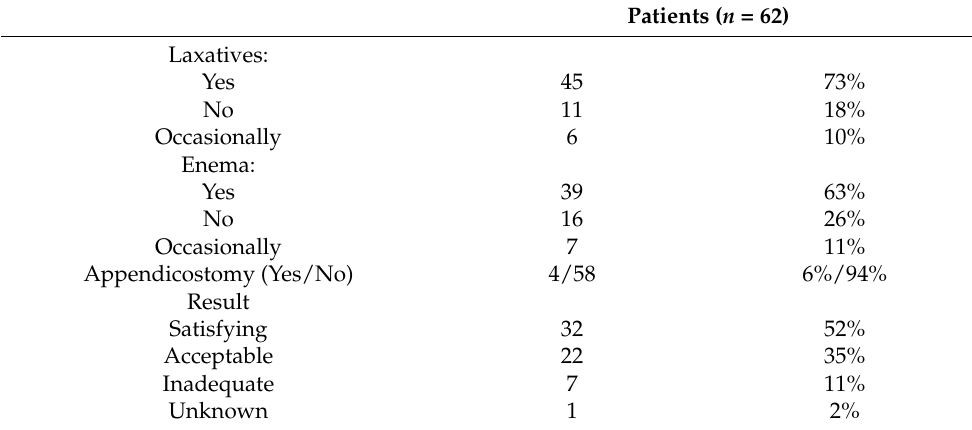
Table 4. Bowel management in 62 patients with spina bifida.